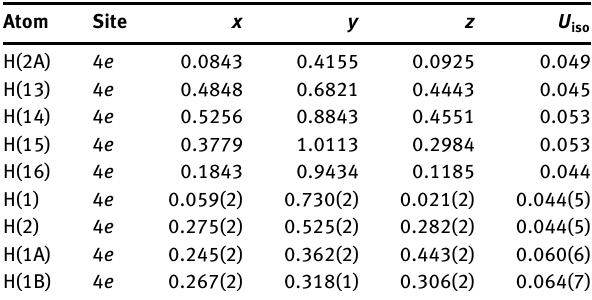
Table 2: Atomic coordinates and displacement parameters (in Å 2